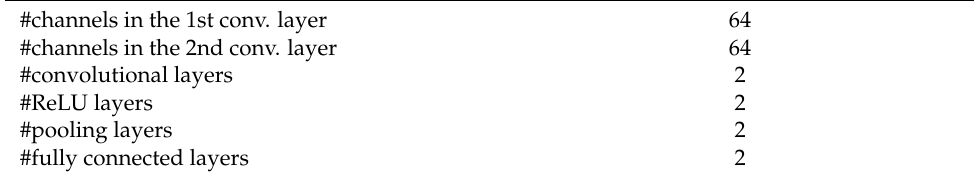
Table 2. Basic Hyper-Parameters of the Bare-bone CNN for CIFAR-10.